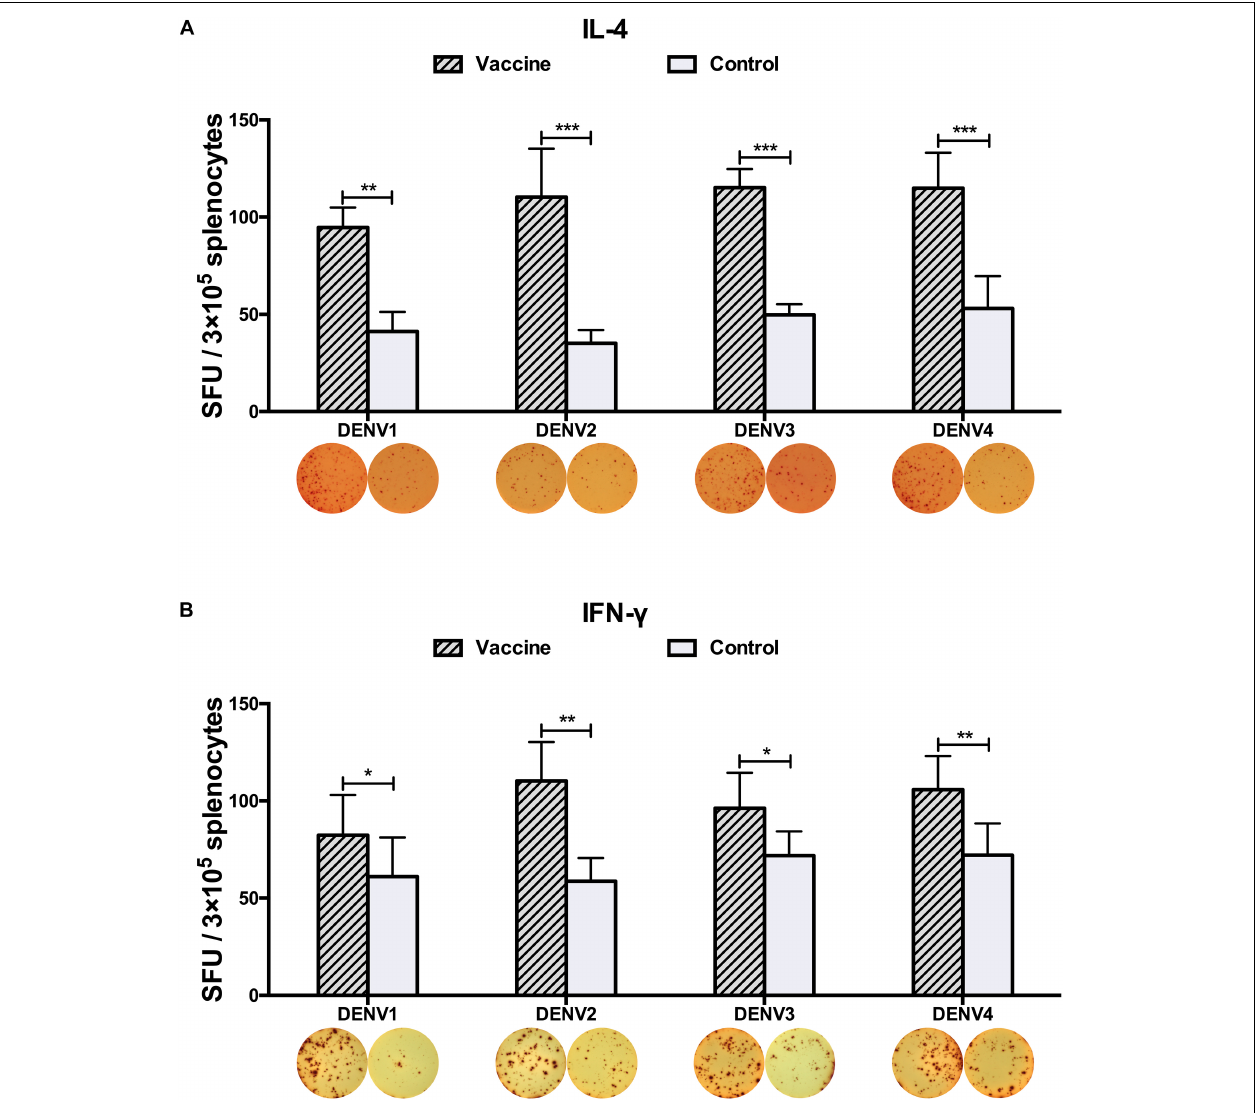
FIGURE 5 | DENV1–4-specific cytokine-secreting splenocytes elicited by the DDP immunization regimen. Cytokine-secreting splenocytes were determined after stimulation with purified DENV1–4 particles, individually. The positive splenocytes were counted and expressed as the mean SFU/3 × 10 5 cells. (A) IL-4-positve and (B) IFN- γ -positive splenocytes with representative ELISPOT images, respectively. Data were expressed as mean + SD ( n = 8). ∗ P < 0.05, ∗∗ P < 0.01, ∗∗∗ P <